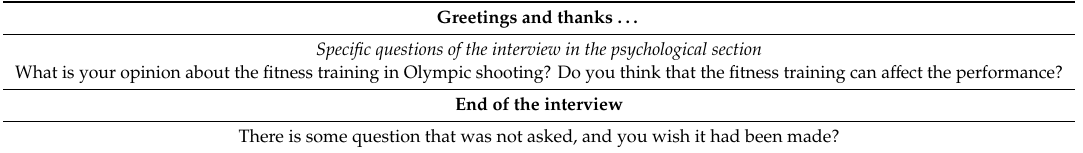
Table 2. Semi-structured interview script. Greetings and thanks